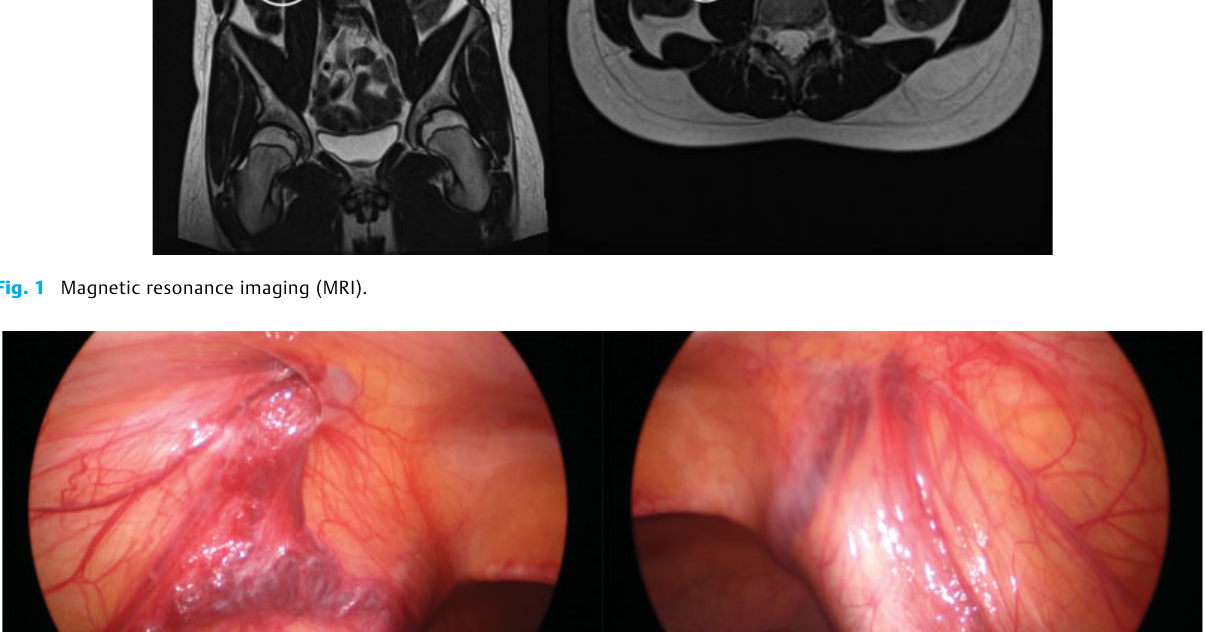
Fig. 2 Laparoscopy: vas and vessels entering deep inguinal rings.